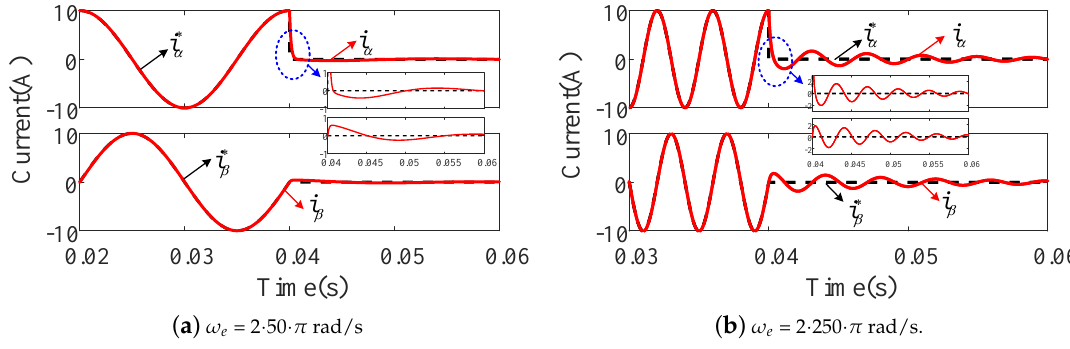
Figure 4. α -axis and β -axis current response with PCI